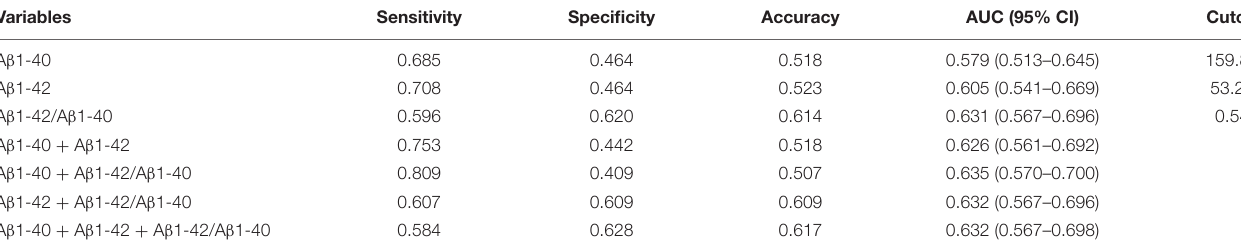
TABLE 2 | Efficacy of different types of plasma A β in diagnosing MCI in the training cohort of T2DM patients. Variables